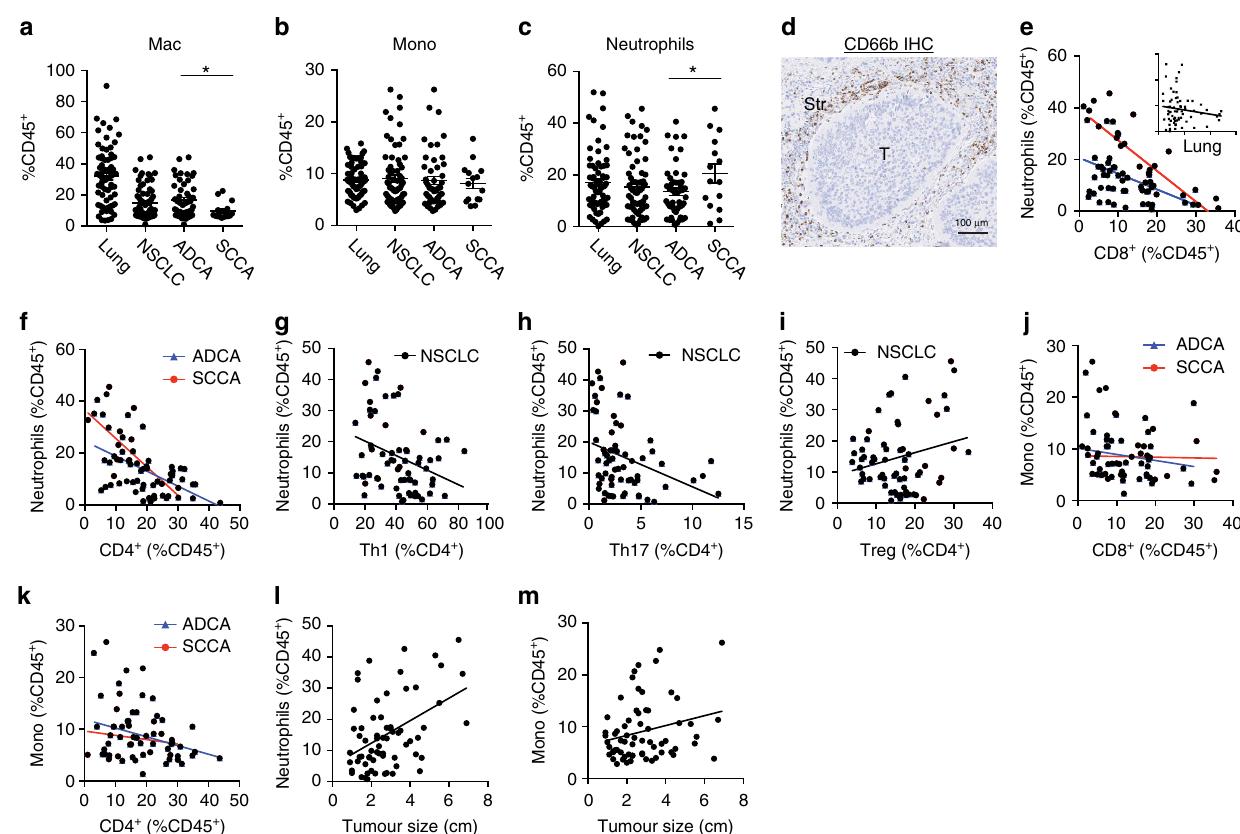
Figure 5 | Neutrophils are the dominant immune cell type in NSCLC. ( a ) Macrophages (L-ADCA versus L-SCCA, * P ¼ 0.0198, N ¼ 64), ( b ) monocytes and ( c ) neutrophils (L-ADCA versus L-SCCA, * P ¼ 0.0328, N ¼ 65) shown as % CD45 þ . ( d ) Representative CD66b IHC depicting neutrophil distribution in stromal (Str) areas in NSCLC. Scale bar, 100 m m. Linear correlation between ( e ) neutrophils and CD8 þ (L-ADCA (blue): * P ¼ 0.0013, R 2 ¼ 0.2000; L-SCCA (red): * P ¼ 0.0008, R 2 ¼ 0.5916, N ¼ 64, lung (inset): P ¼ 0.2285, R 2 ¼ 0.02189, N ¼ 68), ( f ) neutrophils and CD4 þ (L-ADCA (blue): * P o 0.0001, R 2 ¼ 0.3174; L-SCCA (red): * P ¼ 0.0077, R 2 ¼ 0.4592, N ¼ 63), ( g ) neutrophils and Th1 (NSCLC: * P ¼ 0.0079, R 2 ¼ 0.1050, N ¼ 66), ( h ) neutrophils and Th17 (NSCLC: * P ¼ 0.0068, R 2 ¼ 0.1088, N ¼ 66), ( i ) neutrophils and Tregs (NSCLC: P ¼ 0.0623, R 2 ¼ 0.0549, N ¼ 64), ( j ) monocytes and CD8 þ (L- ADCA (blue): P ¼ 0.2403, R 2 ¼ 0.0327; L-SCCA (red): P ¼ 0.9069, R 2 ¼ 0.0011, N ¼ 59) and ( k ) monocytes and CD4 þ (L-ADCA (blue): * P ¼ 0.0172, R 2 ¼ 0.1279; L-SCCA (red): P ¼ 0.5558, R 2 ¼ 0.02970, N ¼ 58). Linear correlations of tumour size and ( l ) neutrophils (* P ¼ 0.0001, R 2 ¼ 0.2034, N ¼ 67) and ( m ) monocytes (* P ¼ 0.0498, R 2 ¼ 0.05878, N ¼ 66) for NSCLC specimen measured by flow cytometry. Student’s tests were performed to compare two groups ( a – c ) and Pearson correlation calculations were performed for linear correlations ( e – m ). All data determined by flow cytometry and each dot represents independent data point. Data are presented as mean ± s.e.m., * P o 0.05 unless otherwise indicated.